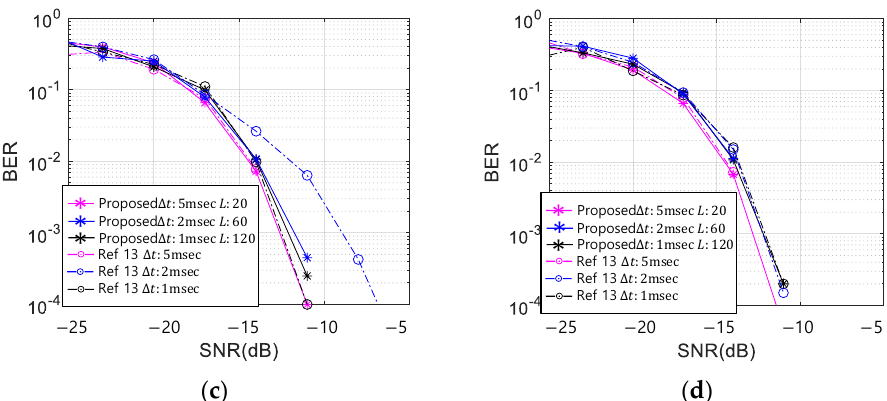
Figure 6. Bit Error Rate (BER) in Additive White Gaussian Noise (AWGN) chirp-rate ( a ); ( a ) 0 Hz/s, ( b ) 1 kHz/s, ( c ) 2.5 kHz/s, ( d ) 5 kHz/s.